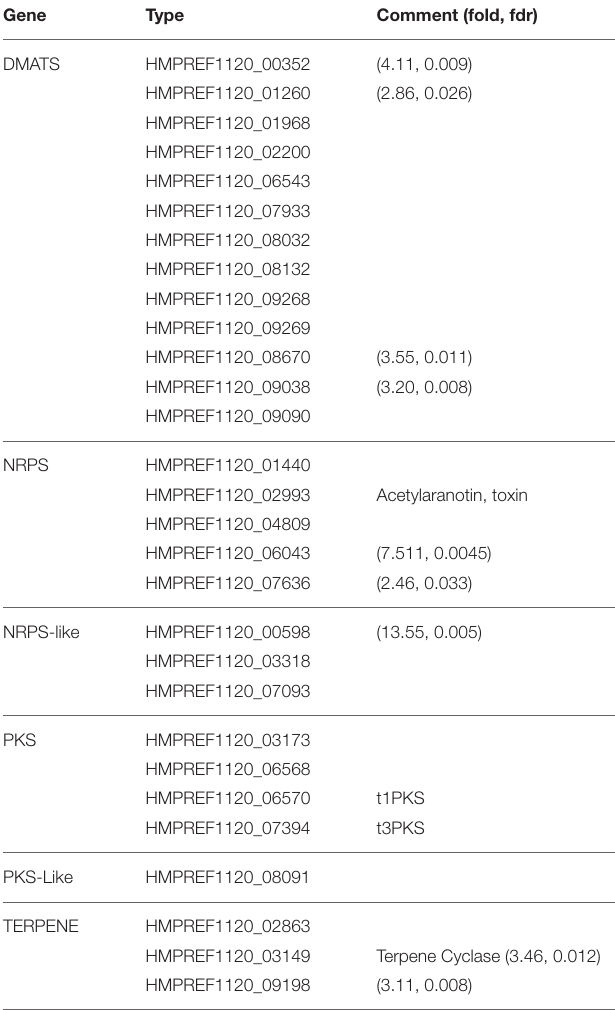
TABLE 2 | List of backbone genes in Exophiala dermatitidis involved in the production of secondary metabolites.